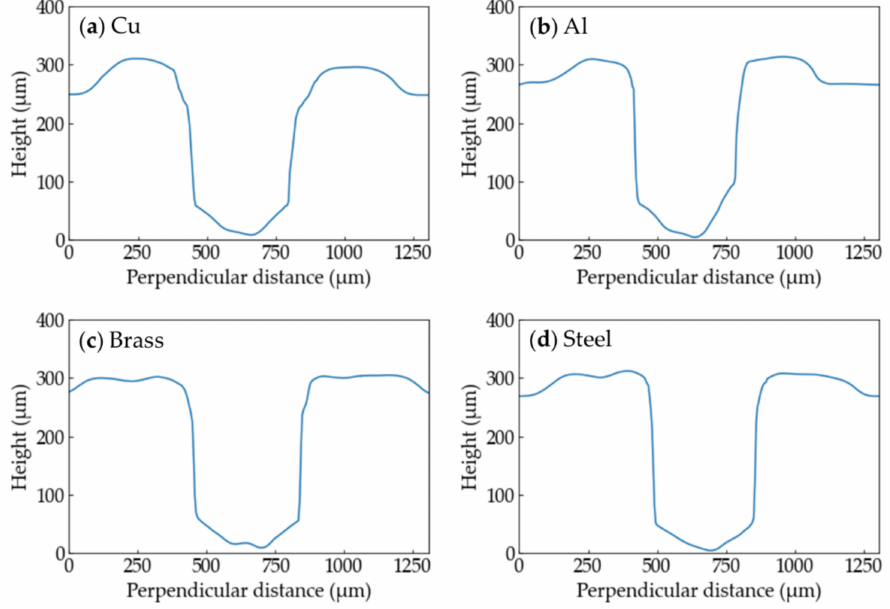
Figure 10. Height profiles of the grooves of the PP samples processed with each metal at E v = 5.1 × 10 10 J/m 3 are shown. ( a ) Cu; ( b ) Al; ( c ) brass; ( d )